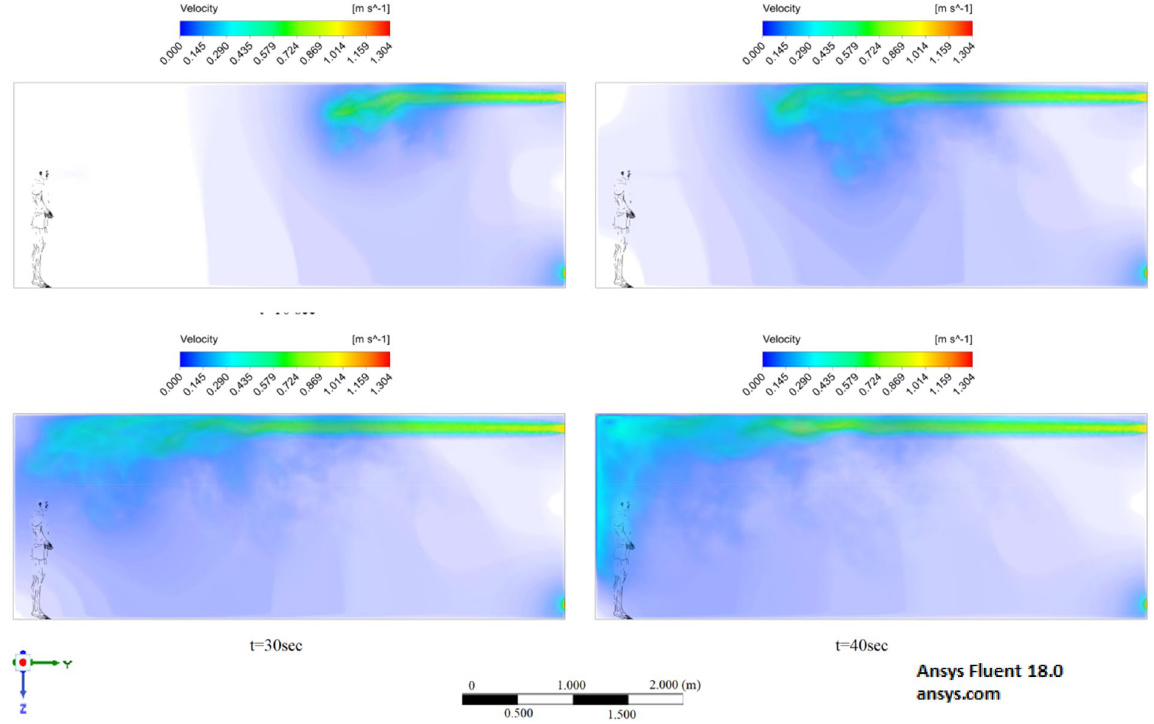
Figure 18. Velocity contours for cough = 1 m/s and ventilation = 1 m/s.